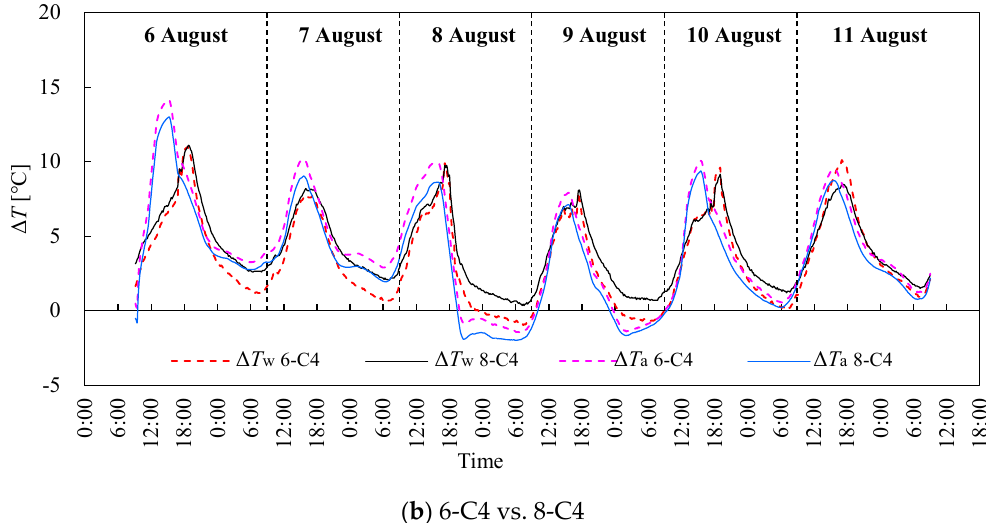
Figure 8. Variation curves of temperature differences between indoors and outdoors ( Δ T a) and the outer and inner surfaces of the exterior wall ( Δ T w) for ( a ) 6-C3 and 8-C3 and ( b ) 6-C4 and 8-C4.